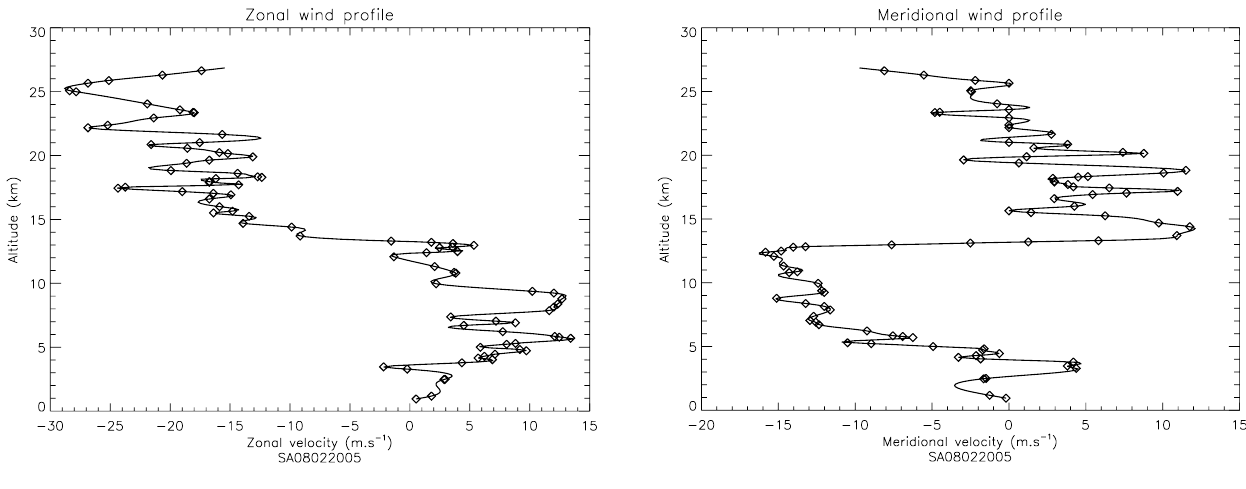
Fig. 8. Case 2: Salta radiosounding. Vertical profile of the wind velocity (ms − 1 ). Diamonds correspond to sounding measurements. Full line is a cubic spline interpolation with vertical resolution of 100m. Left: Zonal wind profile. Right: Meridional wind